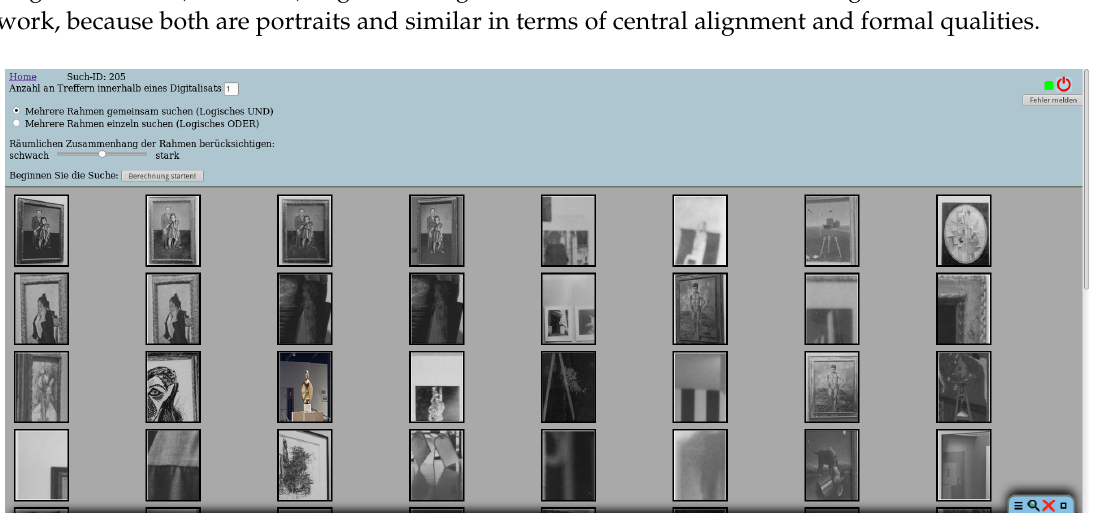
Figure 10. Search results for Balthus’ Joan Miró and His Daughter Dolores (1937, MoMA), second search process based on user’s feedback; van Gogh’s painting L’Arlésienne (Mme. Ginoux) (1888) is highlighted. Previously defined search constraints are visible at the top. Image rights: Computer Vision Group, Heidelberg University. Displayed photographs/details belong to the Museum of Modern Art, New